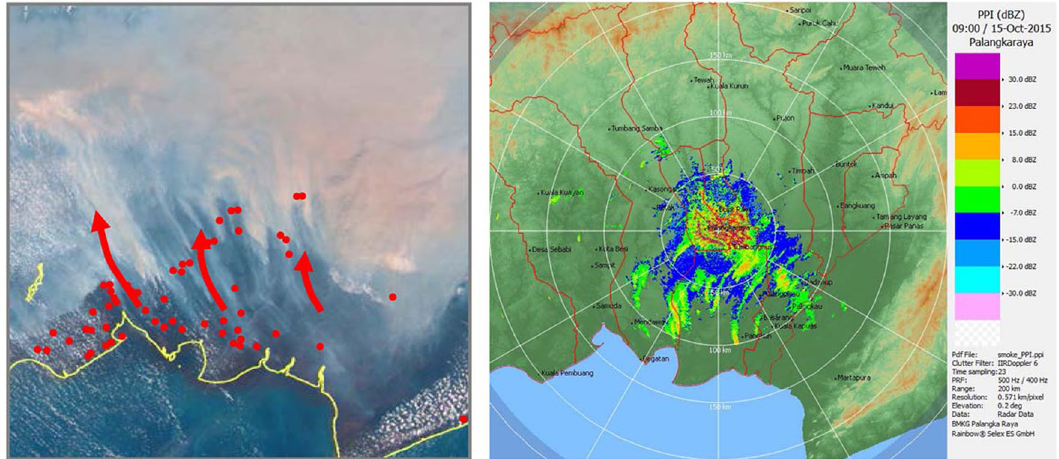
Figure 6. Right: Radar echo image at 09Z(16LT), 15 October 2015. Left: Smoke plumes are observed by AHI/ HIMAWARI-8/JMA satellite. Red dots are MODIS/NASA fire hotspots. Red arrows are forward trajectories at 1000 m altitude using HYSPLIT MODEL/NOAA. (Rainbow 5, https ://www.leona rdoco mpany .com/en/produ cts/rainb ow-5-appli catio n-softw are), (Power Point